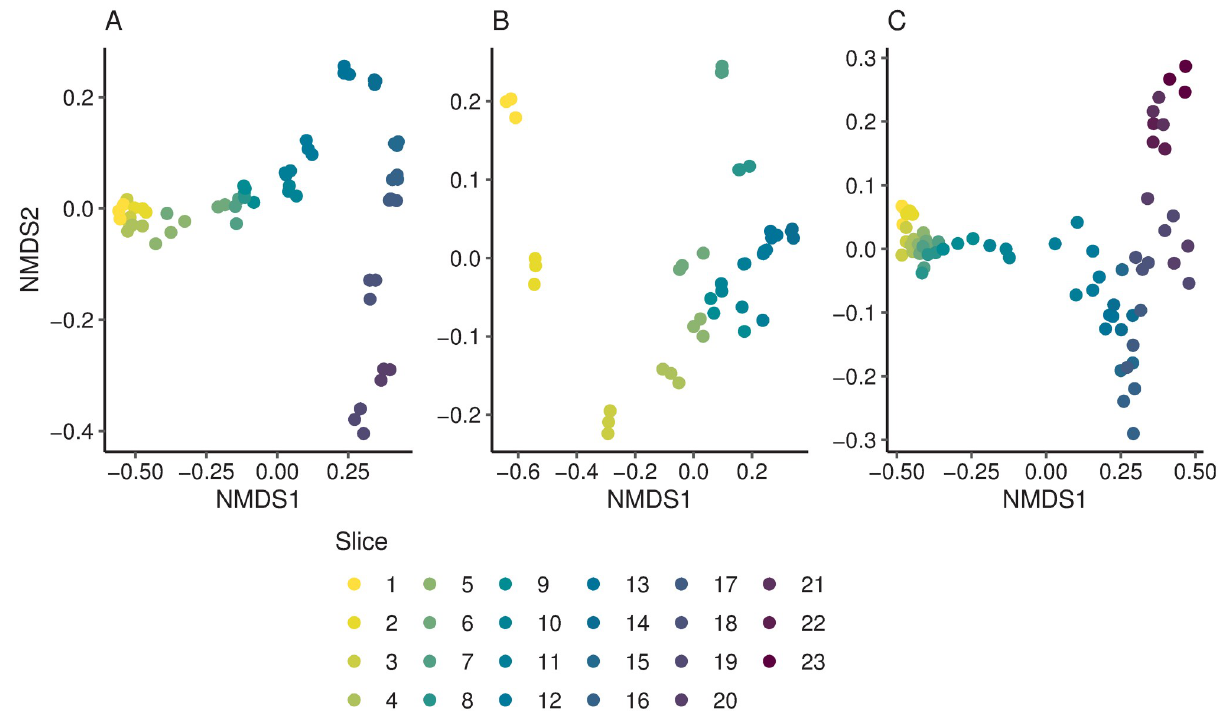
Fig 3. Non-metric multidimensional scaling plot based on Bray Curtis distance matrices for samples taken from Lake Nganoke (A), Lake Paringa (B), and Lake Pounui (C). Points are coloured by depth slice. Approximate ages of slices vary between lakes and are given in S1 Table. Stress values for the non-metric multidimensional scaling (nMDS) plots were Nganoke: 0.048; Paringa: 0.066 and Pounui: 0.055.